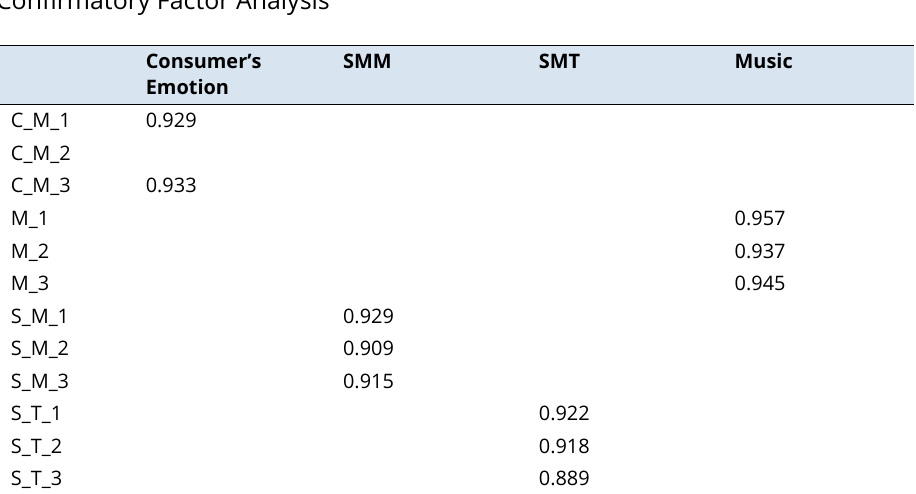
Confirmatory Factor Analysis